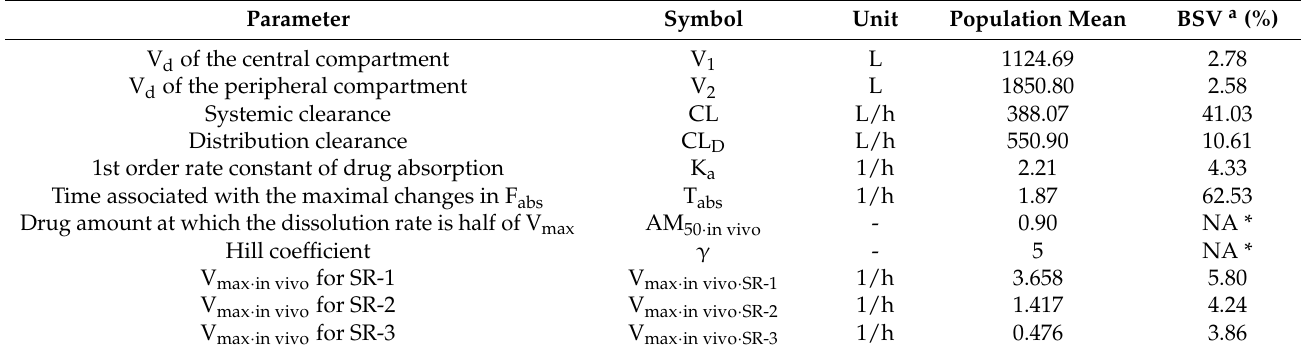
Table 4. The population pharmacokinetic parameter estimates of donepezil.